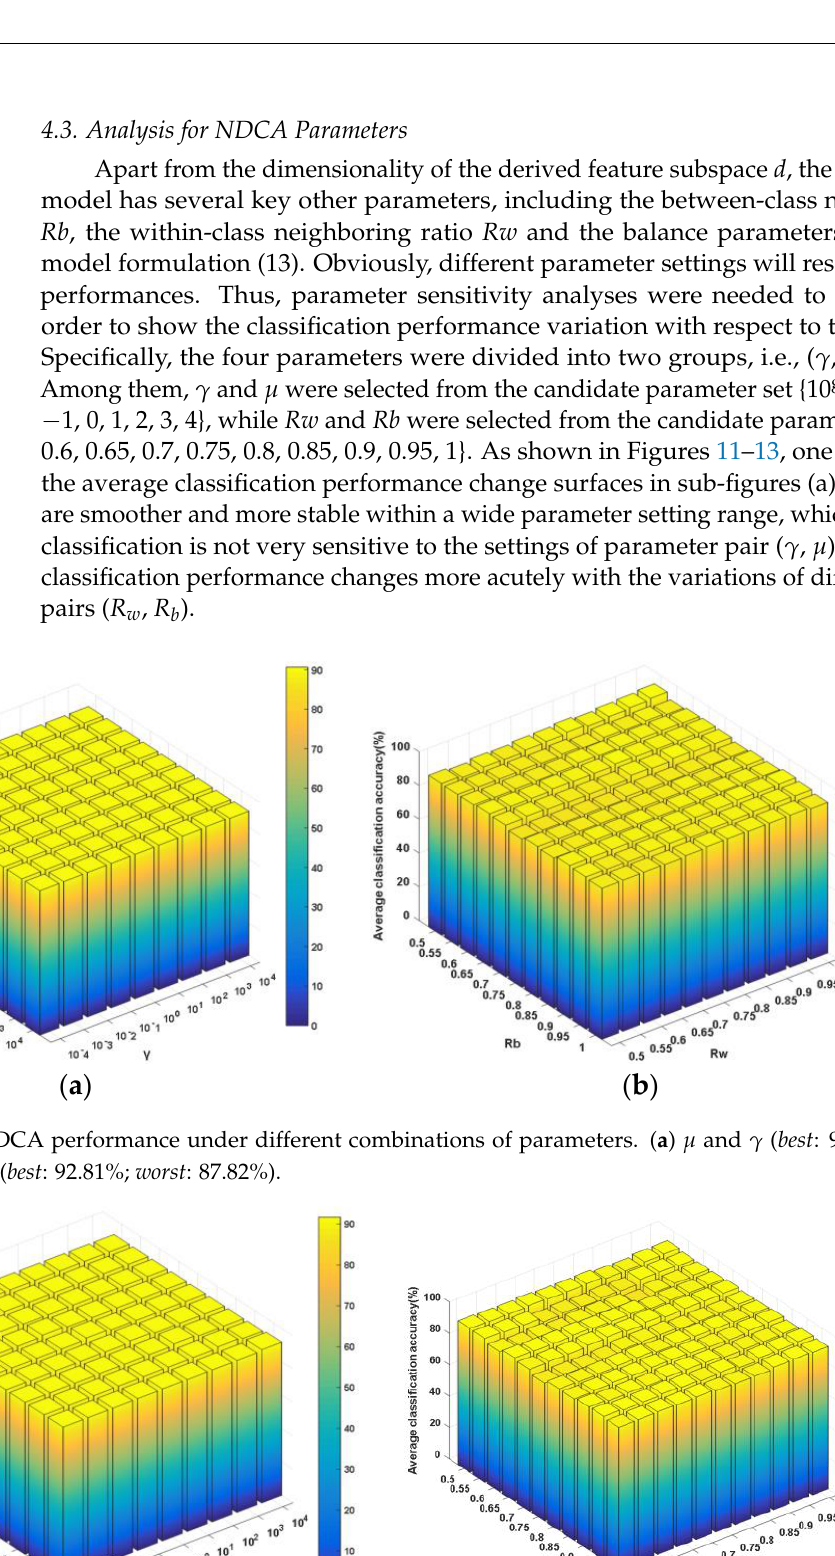
( b ) Figure 13. ELM plus NDCA performance under different combinations of parameters. ( a ) μ and γ ( best : 90.0894%; worst : 88.4365%); ( b ) Rb and Rw ( best : 90.3676%; worst : 87.2660%). 4.4. Analysis for ELM Classifier Parameters The former experiments show that the proposed NDCA method can generally achieve promising and higher classification accuracy in combination with ELM. As shown in formulation (6), ELM has two key hyper-parameters, i.e., the number of hidden neurons L and the balance parameter α . Figure 14 shows that classification performance changes with different settings of L and α . In general, with the increase in the hidden neurons, the classification accuracy increases first and then tends to be stable. In the experiments, the number of hidden neurons L in ELM is empirically set around 9000. As for the trade-off